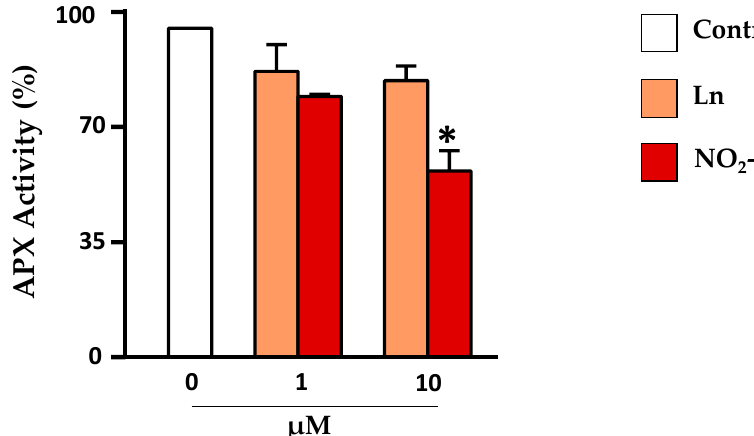
Figure 5. Modulation of the enzymatic activity of cytosolic recombinant APX following the treatment with increasing concentrations of NO 2 -Ln. The negative controls methanol (NO 2 -FA vehicle) and linolenic acid (non-nitrated fatty acid) were used. Vertical bars represent the mean ± standard deviation of at least three replicates. Statistically significant differences p < 0.05 (*) and p < 0.01 (**). (Ascorbate peroxidase: